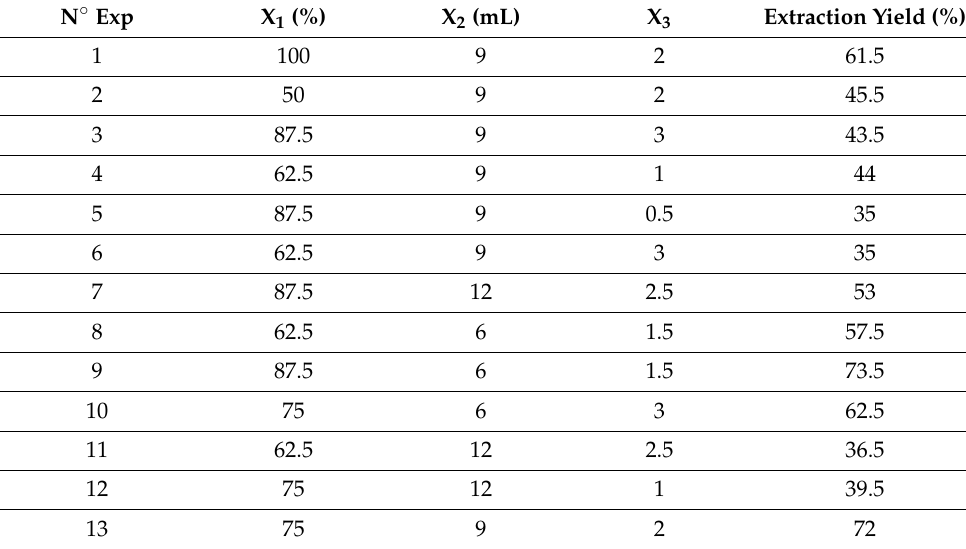
Table 1. Boehlert experimental design and the obtained